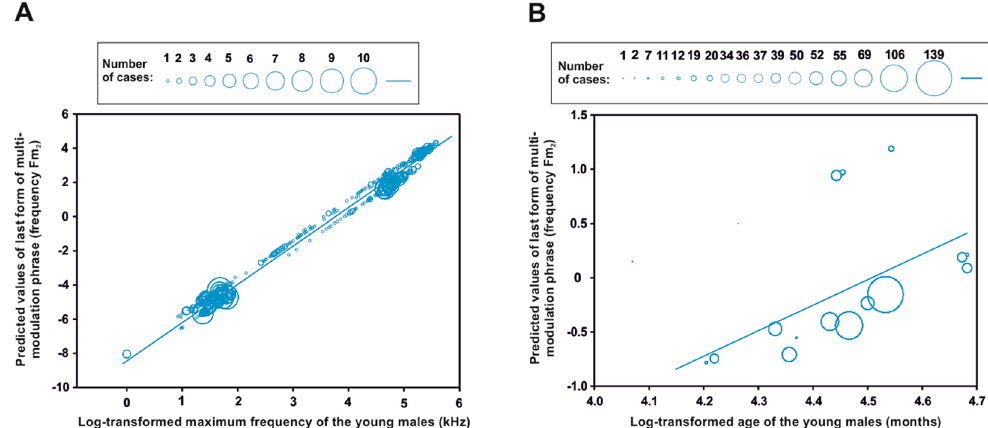
Figure 6. Charts showing development of the male vocal pattern: ( A ) predicted values of the last form of a multi-modulation phrase (frequency Fm 2 ) plotted against the log-transformed maximum frequency of calls emitted by the young males; and ( B ) predicted values of the last form of a multi-modulation phrase (frequency Fm 2 ) plotted against the log-transformed age (months) of the young males. Values for each cases indicate the number of frequency modulations (two or more) in the second note of a mature form of the multi-modulation phrase (Fm 2